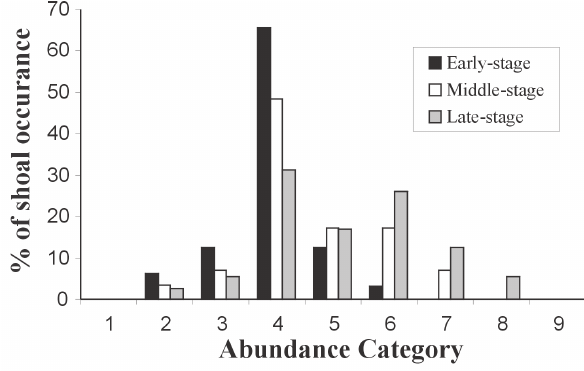
Fig . 2. – distribution of the percent occurrences per abundance cat- egory for the three specified ontogenetic